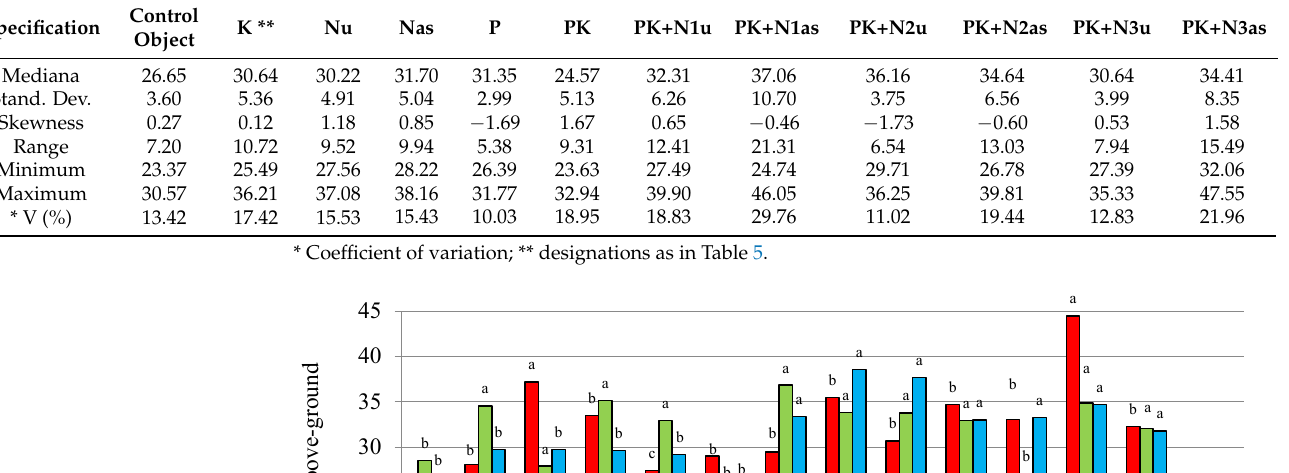
Table 6. Descriptive statistics of the JA aboveground biomass yield depending on fertilization (means for cultivars and years 2016–2018).